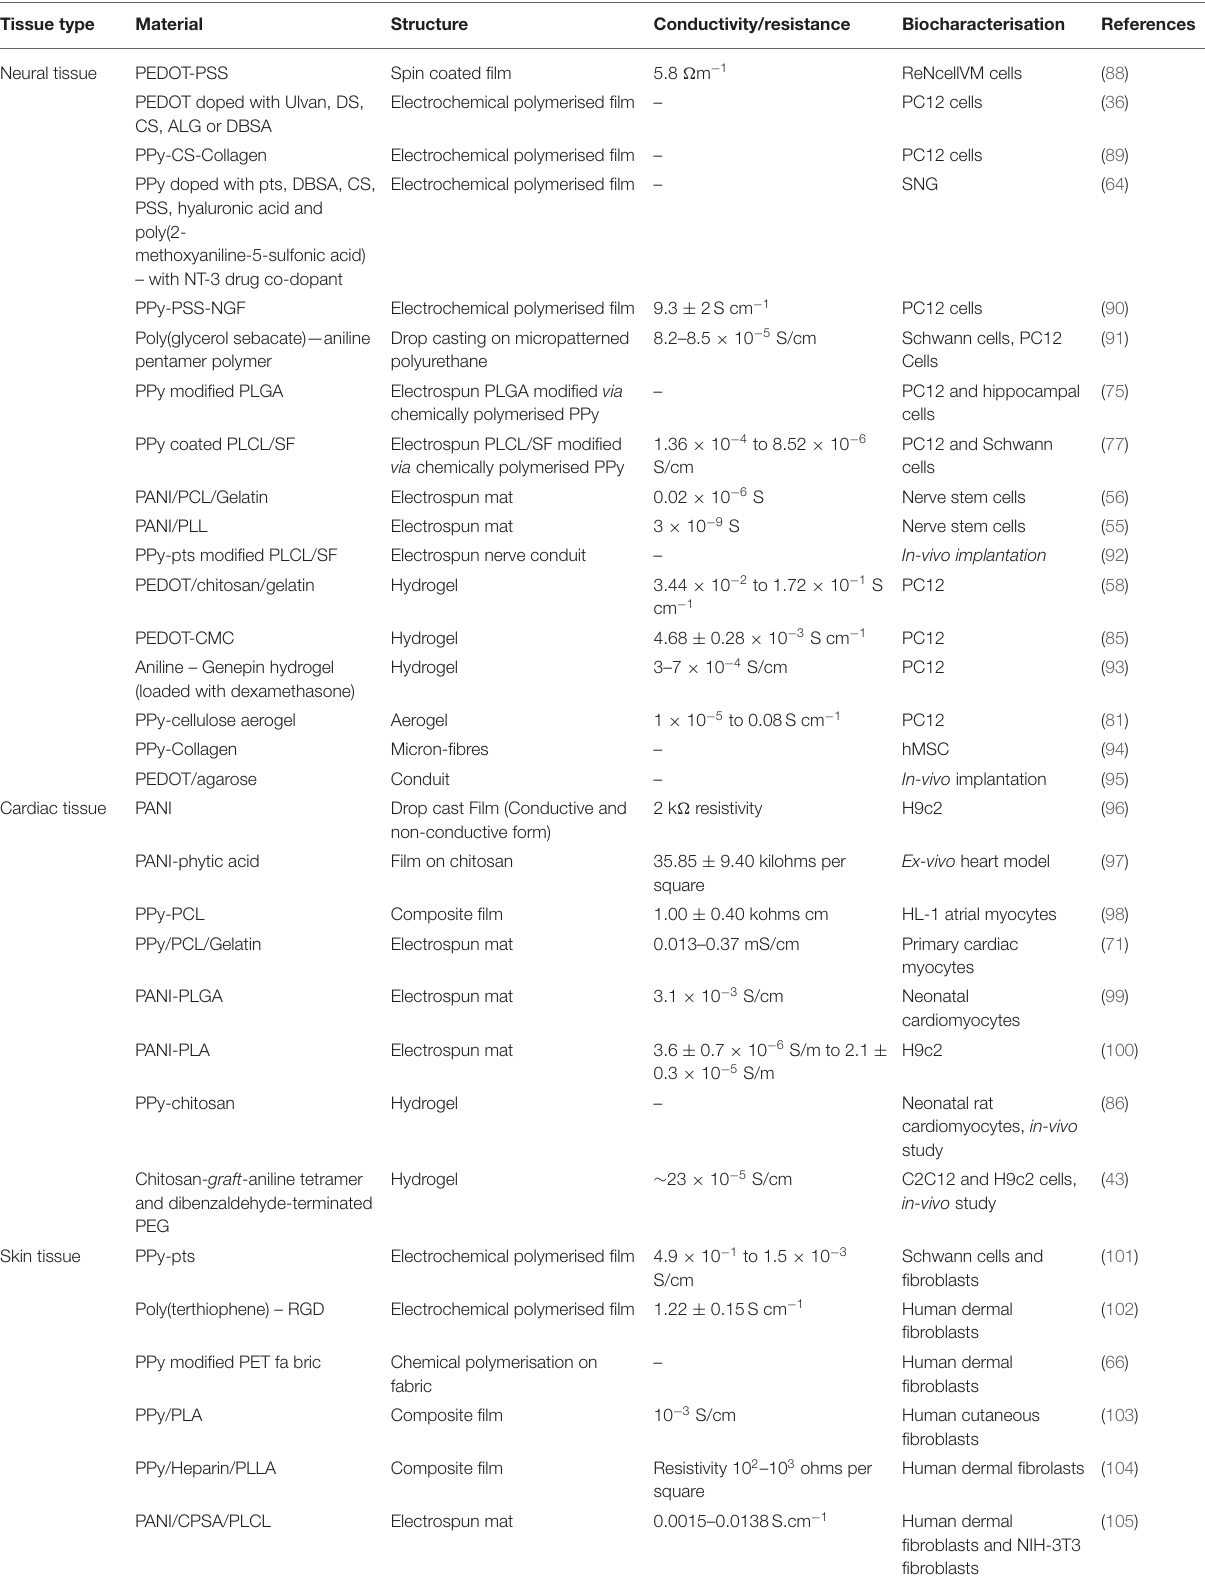
TABLE 2 | Summary of studies describing conducting polymer biomaterial application for tissue engineering. Tissue